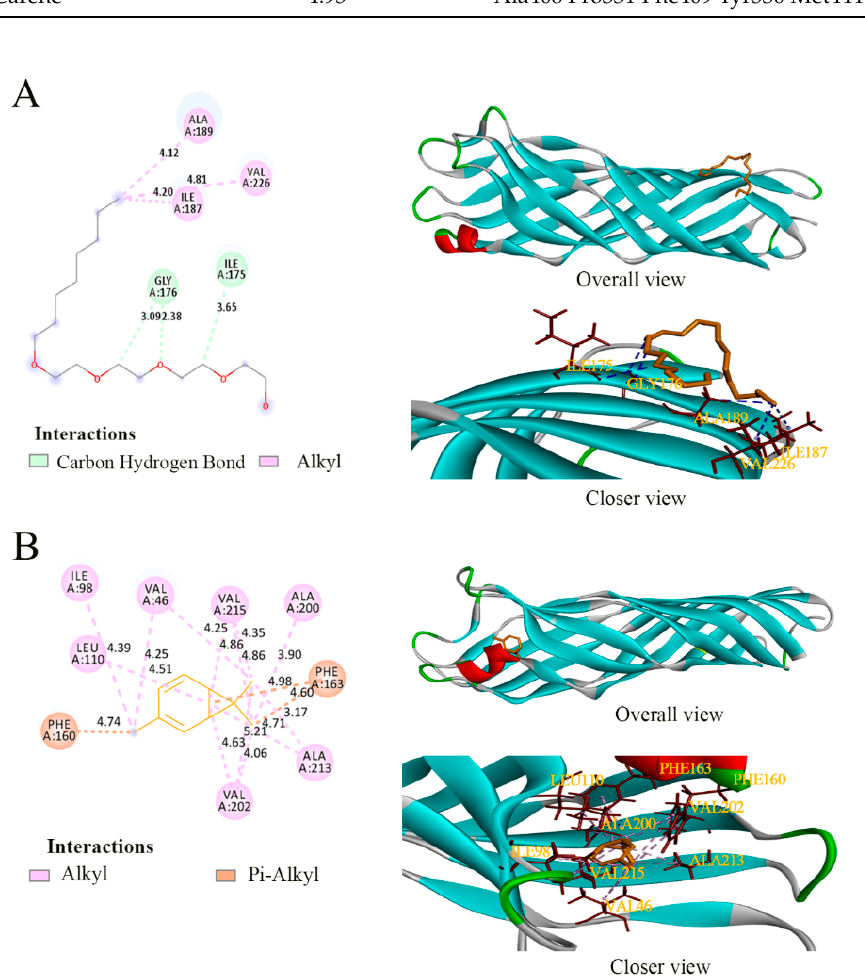
Figure 8. The binding details of OmpW with (hydroxyethyloxy) tri (ethyloxy) octane ( A ) and 3-carene ( B ).